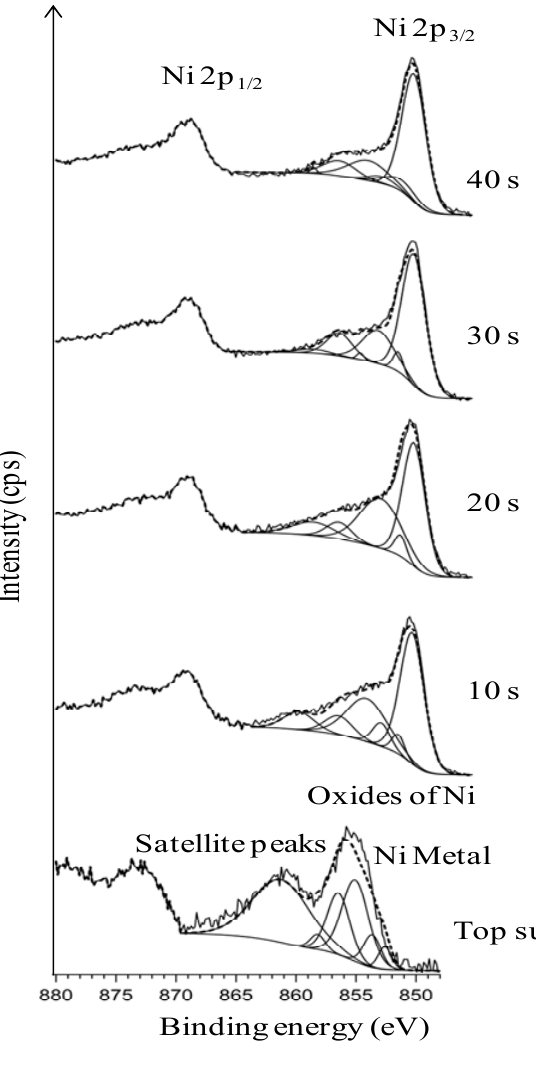
Figure 11. XPS depth profile studies of Ni peaks after thermal cleaning followed by chemical cleaning with etching for 15 min (with deconvolution for the presence of